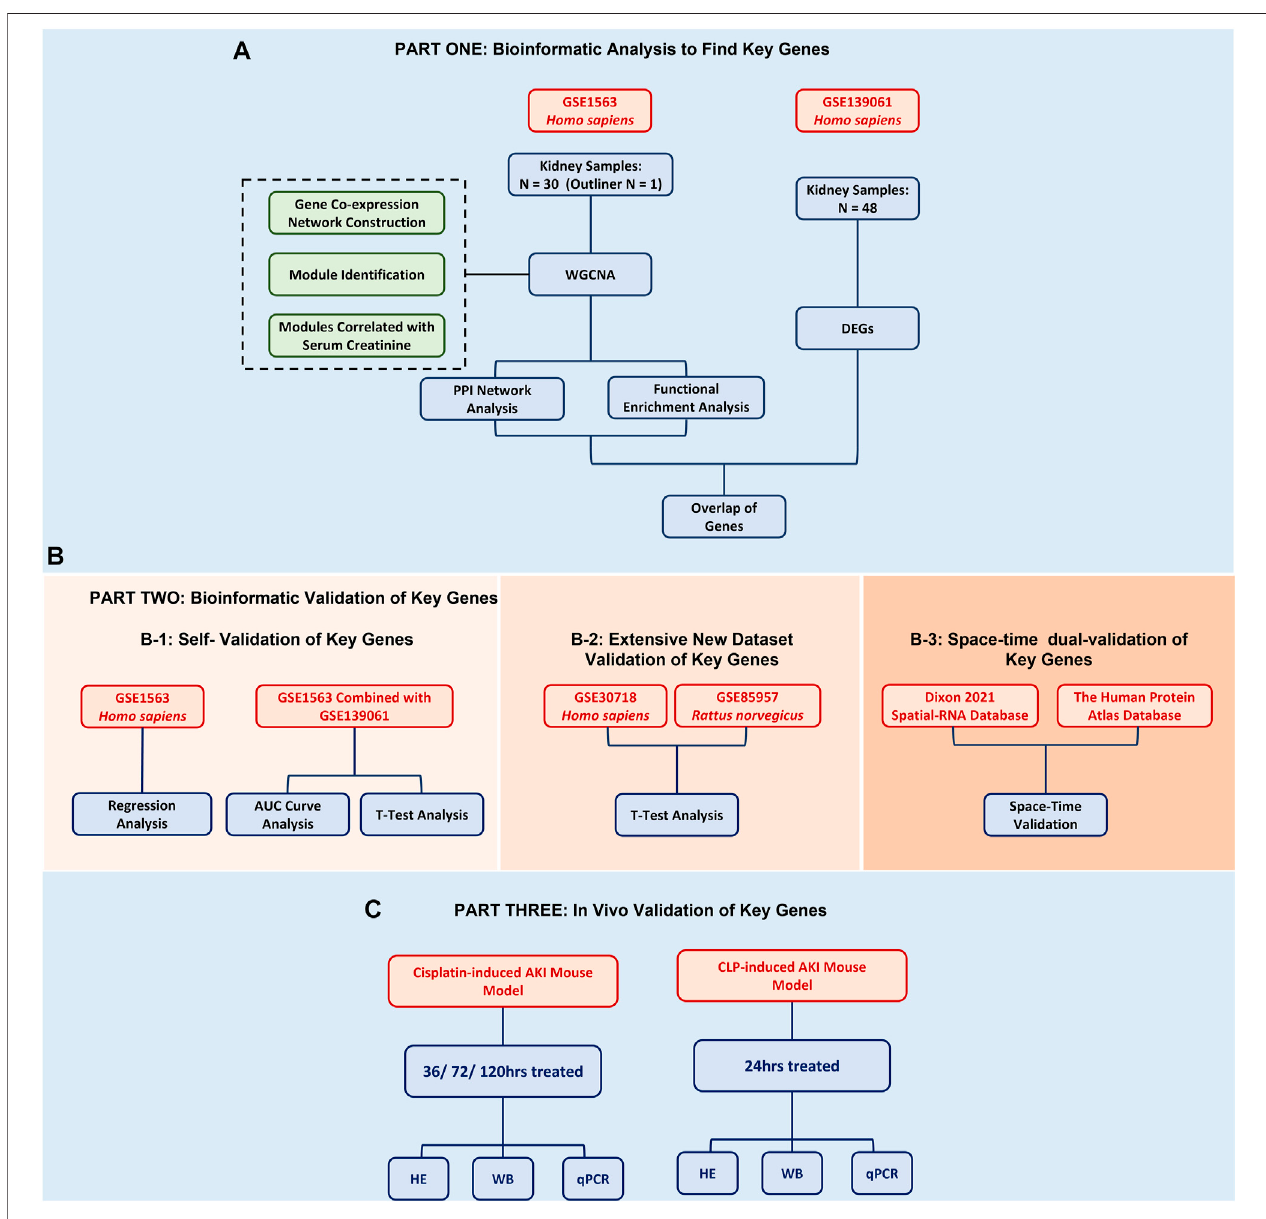
FIGURE 1 | Flowchart of the bioinformatic analysis and experimental